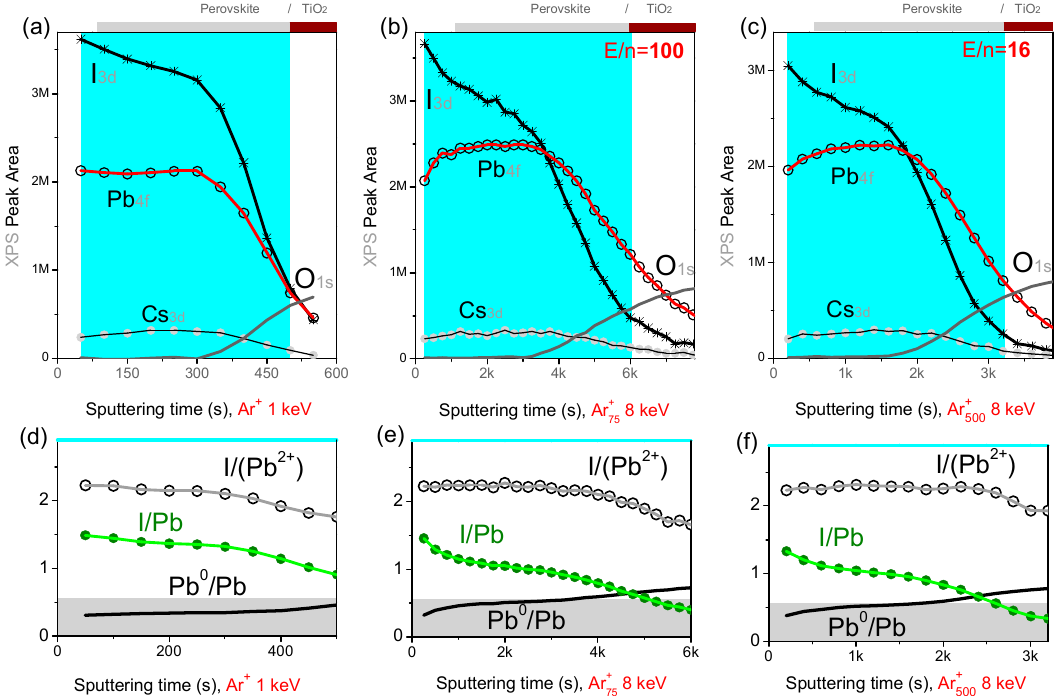
Figure 3. XPS depth profiles acquired on Perovskite/cTiO2 model samples obtained with ( a , d ) monoatomic Ar + at 1 keV; ( b , e ) Ar 75+ clusters at 8 keV; and ( c , f ) Ar 500+ clusters at 8 keV. Bottom panels show atomic percent ratios between iodide and lead which are present in two different chemical states (Pb 0 and Pb +2 from the perovskite). Bottom panels refer to the perovskite layer highlighted in the top panels for which the upper limit corresponds to the O 1s signal (from cTiO 2 ) reaching 70% of its plateau value.